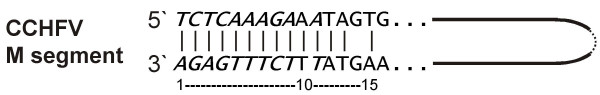
Schematic presentation of the predicted base-paired ends of the CCHFV M vRNA segment. The first nine nucleotides as well as nucleotides at position 11 at both RNA ends are highly conserved within the three genome segments (bold, italics), whereas the first thirteen nucleotides at the 3' and 5' vRNA ends are inverted complementary and can form base-paired terminal regions.